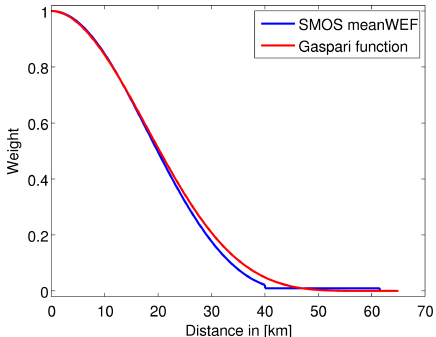
Figure 5. Weighing functions for the observation matrix H compar- ing the function used for the SMOS antenna pattern and the Gaspari function used in this